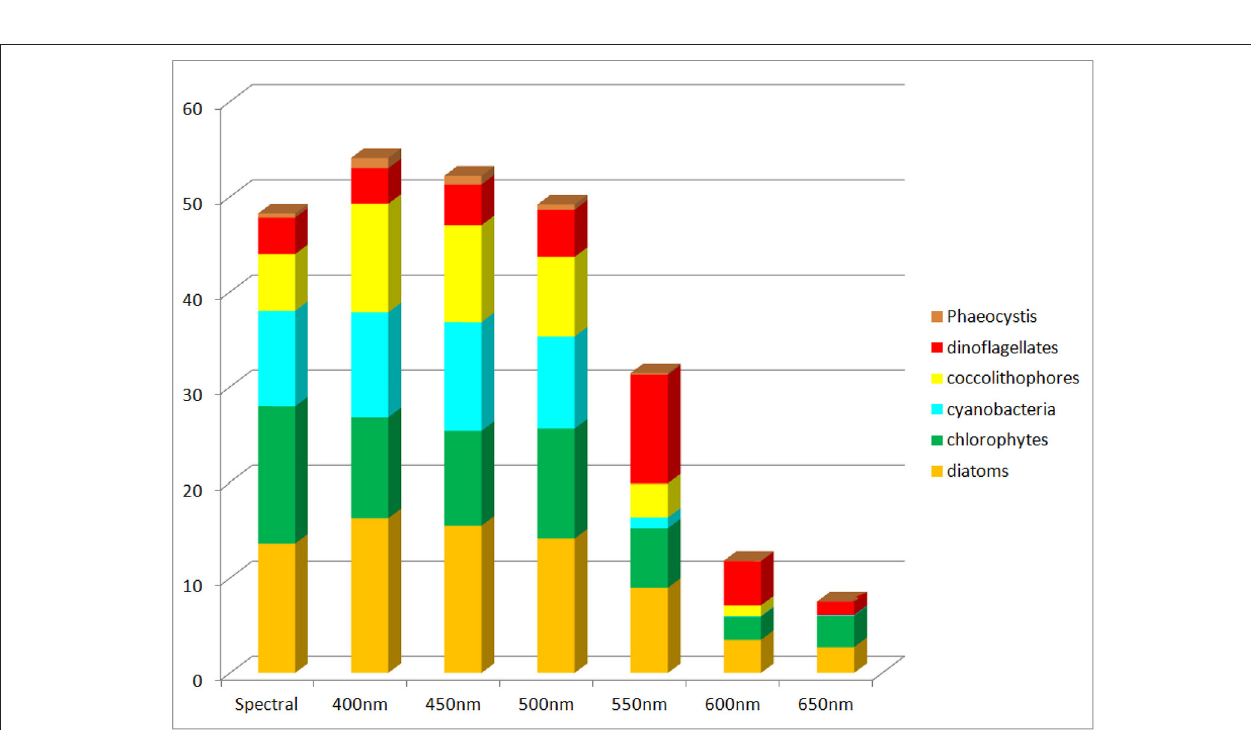
Frontiers in Marine Science |